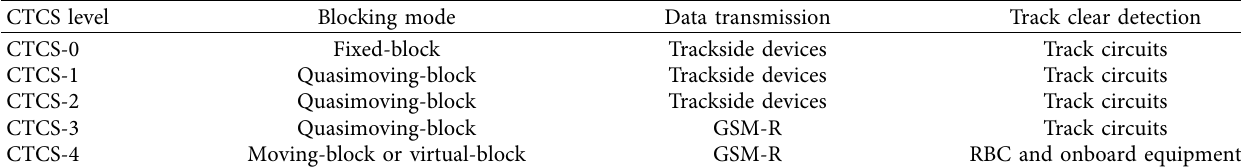
Table 1: Characteristics of CTCS